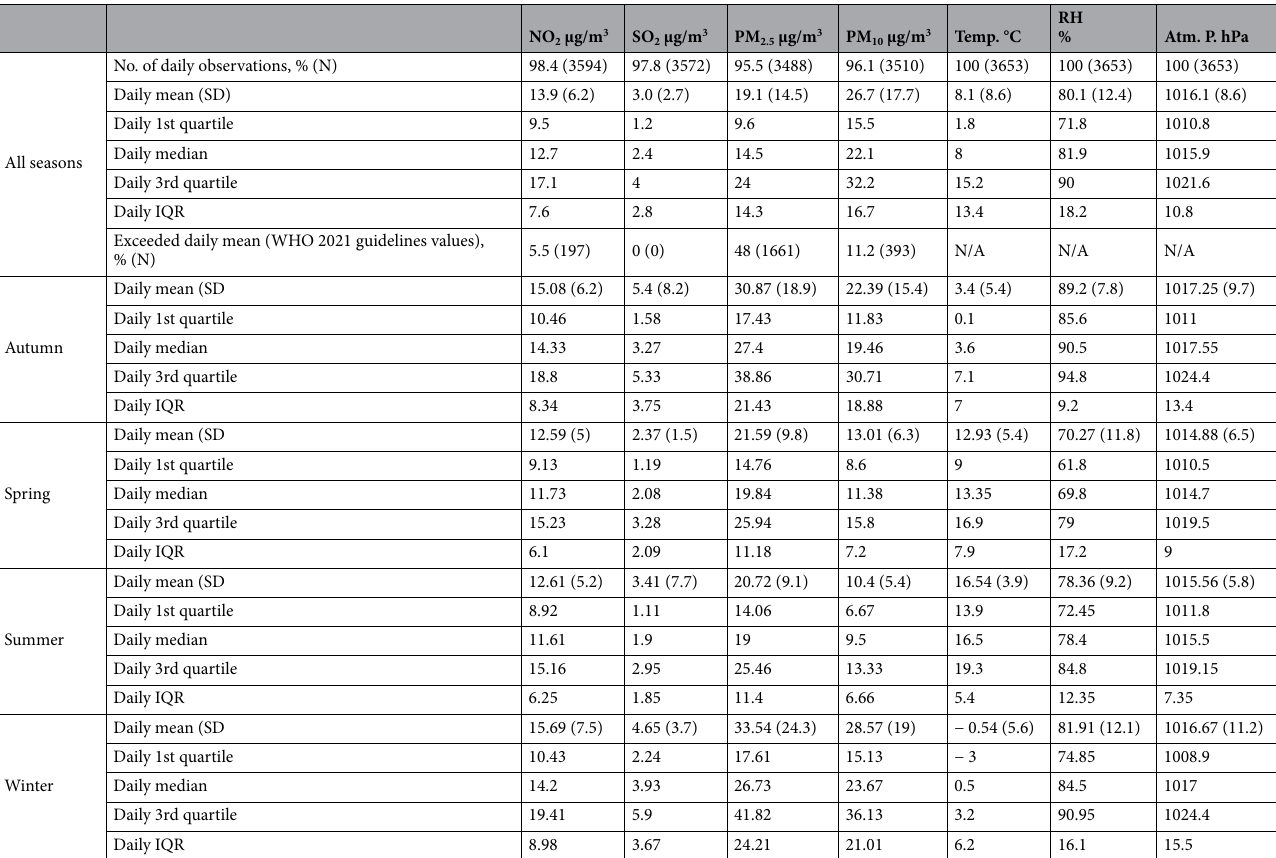
Table 4. Statistics for daily concentrations of air pollutants and weather conditions in the period of 2011–2020. Atm. P., atmospheric pressure; IQR, interquartile range; N/A, not applicable; N/D, no data;